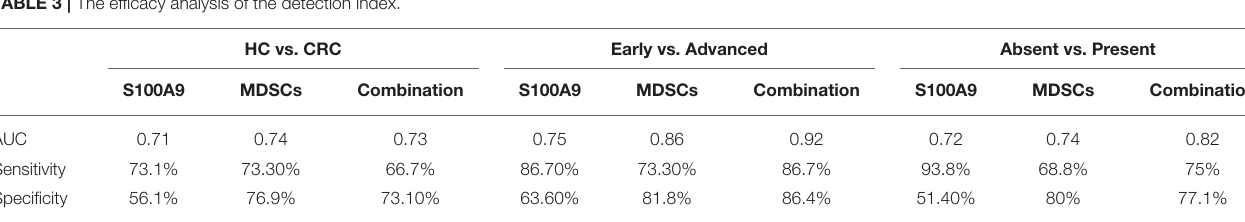
TABLE 3 | The efficacy analysis of the detection index. HC vs. CRC Early vs. Advanced Absent vs. Present S100A9 MDSCs Combination S100A9 MDSCs Combination S100A9 MDSCs